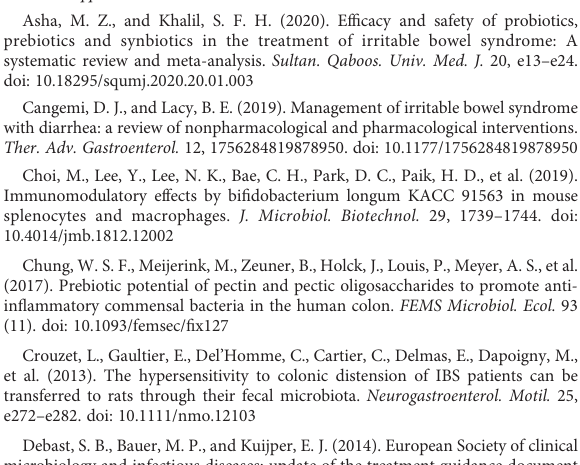
SUPPLEMENTARY TABLE 3 Changes in quality of life scale scores IBS-QoL. SUPPLEMENTARY TABLE 4 Changes in anxiety and depression scale